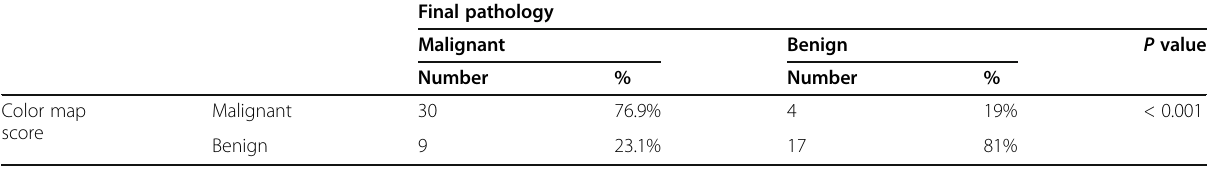
Table 2 Relation of the results of colour-coded map scoring of SWE (qualitative analysis) and those of final